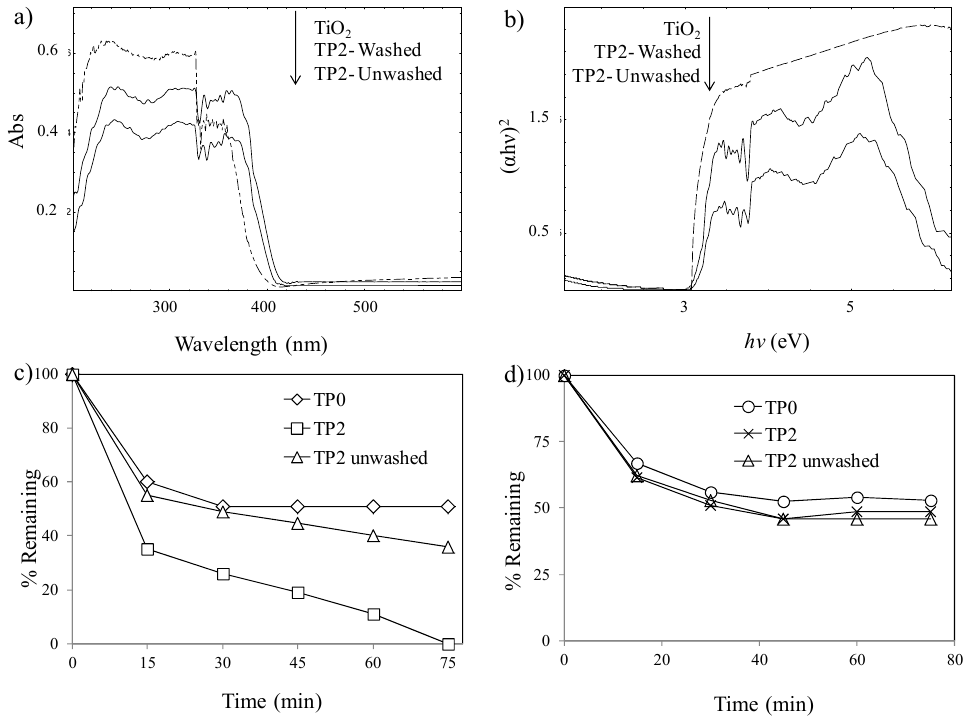
Figure 7. Graph plots for: ( a ) UV–Vis diffuse reflectance spectra (DRS); ( b ) Tauc’s equation; ( c ) percentage remaining of MB dye under visible light irradiation; and ( d ) adsorption study. Abs, absorption.